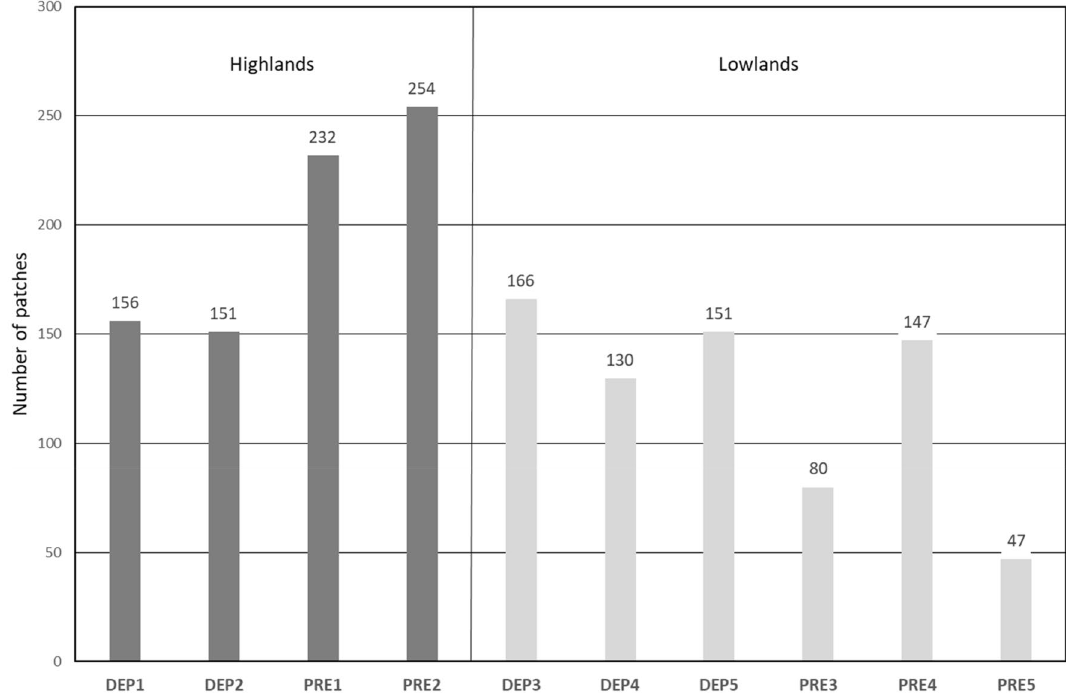
Figure 7. Number of patches with change trajectories of agricultural land—forest and agricultural land—non- forest woody vegetation in the depopulated and non-depopulated areas. Study